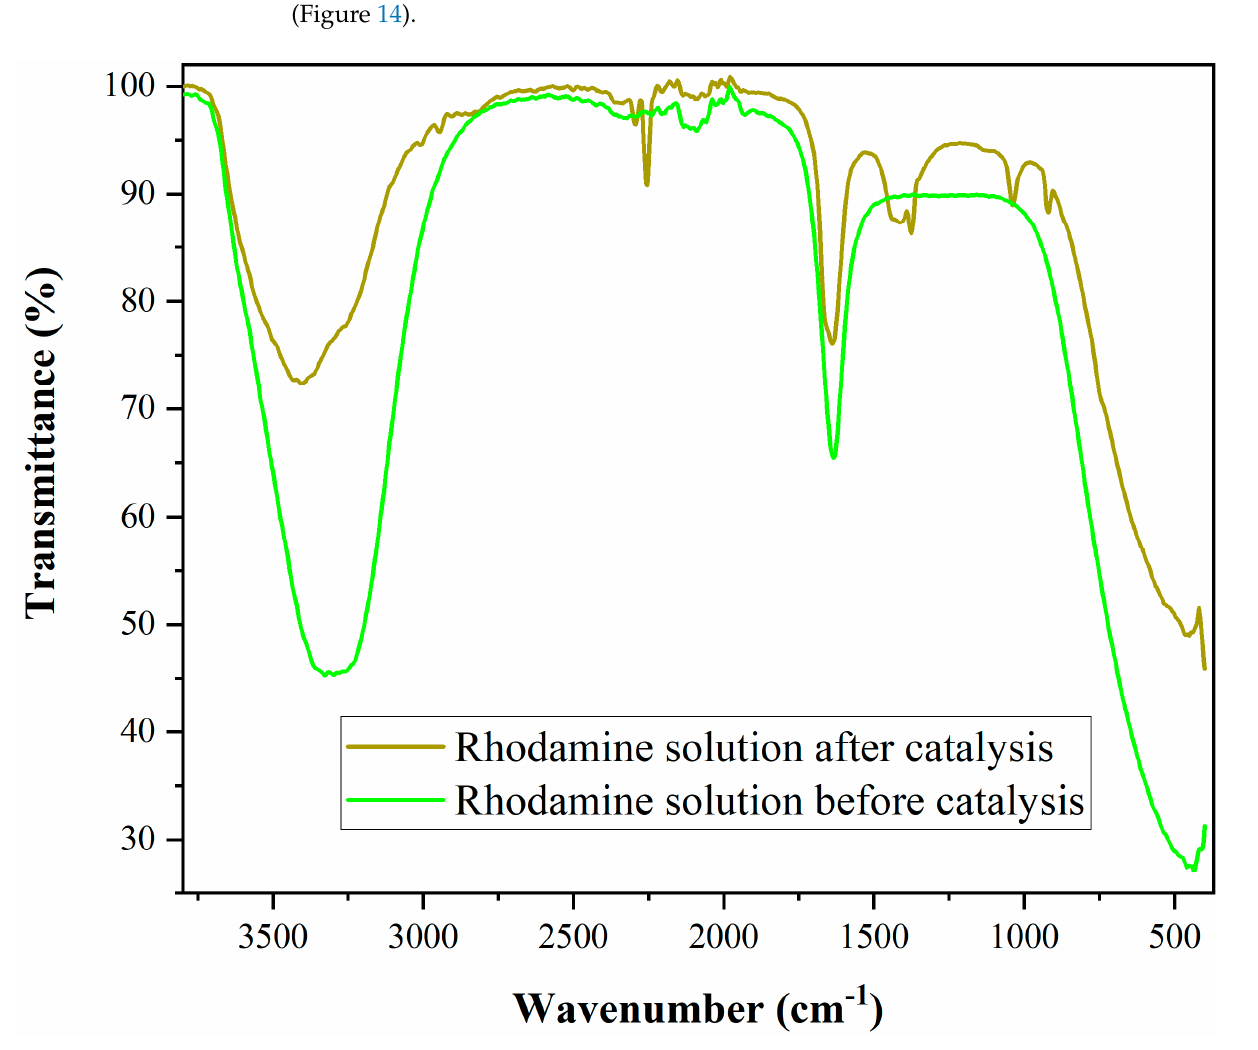
Figure 14. FTIR spectra of rhodamine solution before and after catalytic oxidation. FTIR spectroscopy was used to identify the presence or absence of some bonds before and after the oxidation. It was observed that the band found for rhodamine before catalysis at 3306 cm − 1 (assigned to the presence of secondary amine) decreased in intensity after the catalytic reaction, indicating its partial destruction in rhodamine. This band overlapped with the new band at 3429 cm − 1 , indicating the formation of –OH. Still-existing absorption bands of conjugated carbonyl at 1640 cm − 1 , as well as the new band at 3432 cm − 1 (–OH), indicated the formation of carboxyl groups after catalysis [58]. After oxidation, a band appeared at 924 cm − 1 attributed to N–H stretching vibrations. The appearance of new bands at 1375, 1415, and 2255 cm − 1 demonstrated the total disrup- tion of aromatic rings. Similar results were found for rhodamine B degradation using Coe- lastrella sp. green microalgae [59]. The FTIR results showed that dye molecules were trans- formed into small-molecular-weight organics and inorganics, which were less harmful, and finally completely converted to CO 2 , water, and some inorganic anions. The rhodamine solution, after catalyst usage, was subjected to SAA analysis, the re- sults indicating a concentration of Ni and Fe under the method quantification limits: un- der 50 μ g/L for Ni ions and under 70 μ g/L for Fe ions. These results suggest that the cata- lysts are very stable during the oxidation reaction. The literature mentioned that the Fe catalysts are more active than the Ni catalysts [60], but under photocatalytic conditions, where it is well known that Fe ions together